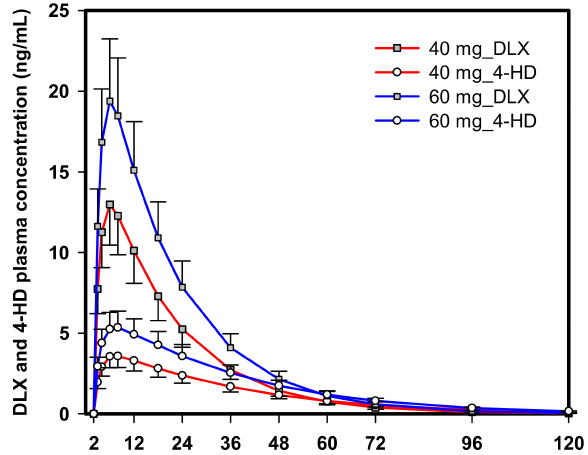
Figure 5. Extrapolated concentration-time curve profiles of DLX and 4-HD after a single oral administration of 40 mg or 60 mg in humans. Data are presented as means (solid square, DLX and open circles, 4-DH) and standard deviations (error bars). Table 4. Pharmacokinetic (PK) parameters of DLX in humans according to di ff erent co-administered doses of